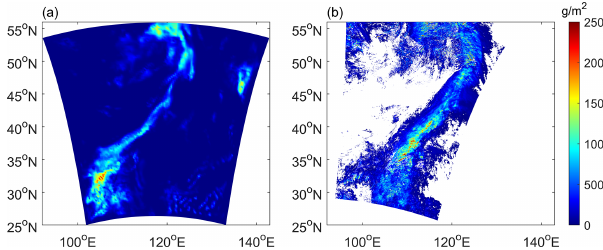
Figure A1. Comparison of the cloud water path (CWP) between the WRF model result and MODIS data for the stratiform case. (a) the CWP from the WRF simulation at 03:30UTC and (b) the CWP from the MODIS observation at 03:35UTC, 25 September